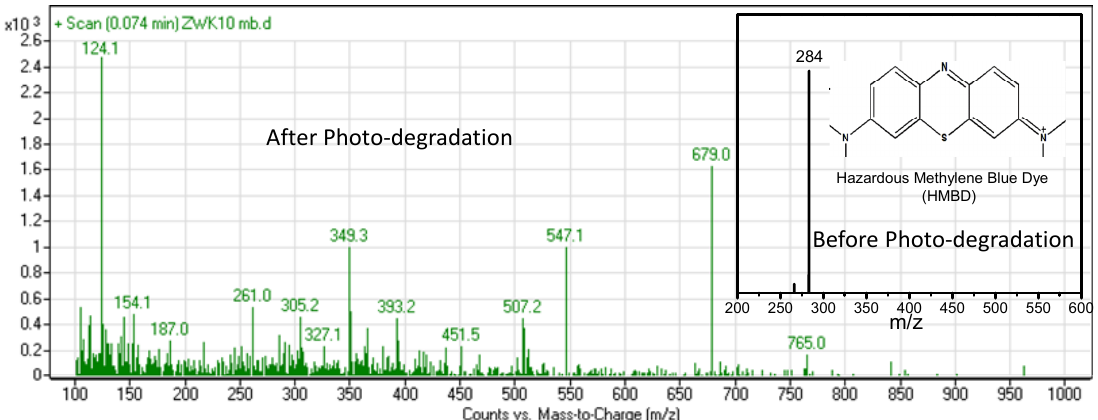
Figure 7. ESI-MS spectra of HMBD solution before and after photo-catalytic degradation.